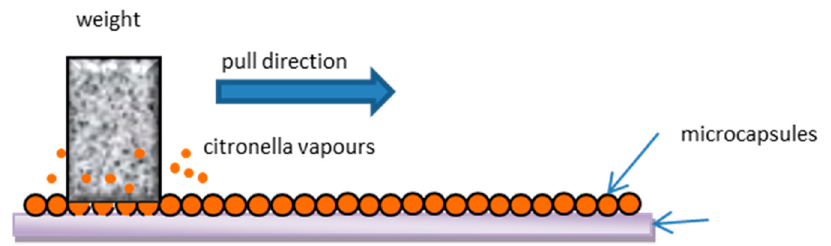
Figure 2. Mechanical activation of coated papers containing citronella oil microcapsules with weight pulling test.